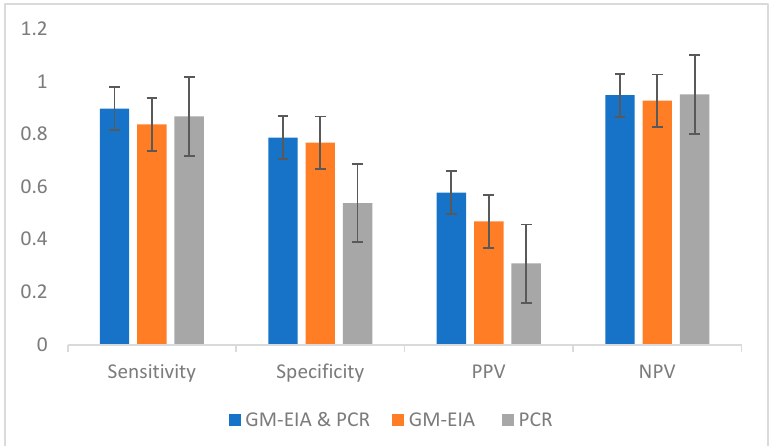
Figure 1. Aspergillus sp. culture-positive specimens ( n = 172) analyzed via direct microscopy (gold standard), Aspergillus PCR, and galactomannan enzyme immunoassay testing (GM-EIA). PPV, pos- itive predictive value; NPV, negative predictive value.